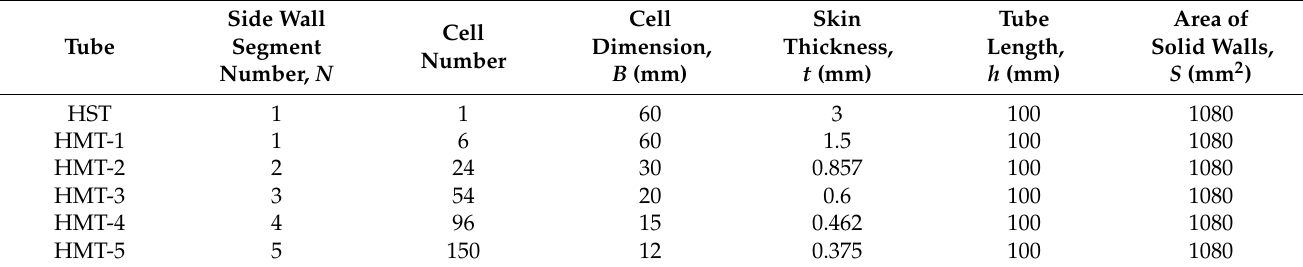
Figure 1. Topology of HMTs with different side segments. Table 1. Dimensions of designed hexagonal thin-walled tubes.